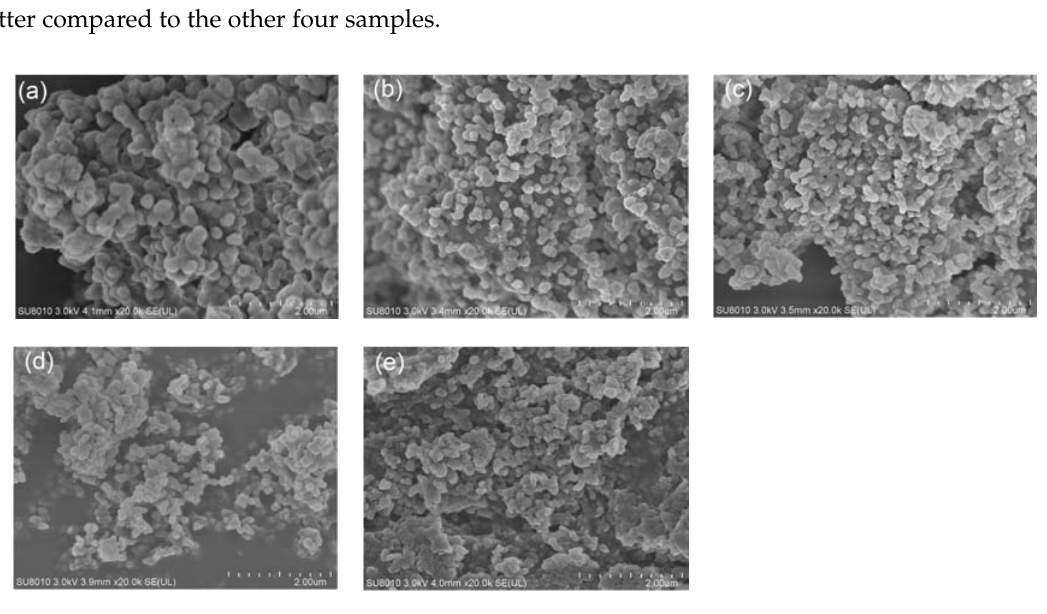
Figure 6. SEM images of micro ‐ nanocapsules prepared with different amounts of emulsifier: ( a ) Sample 1, R EC = 5%; ( b ) Sample 2, R EC = 10%; ( c ) Sample 3, R EC = 15%; ( d ) Sample 4, R EC = 20%; ( e )